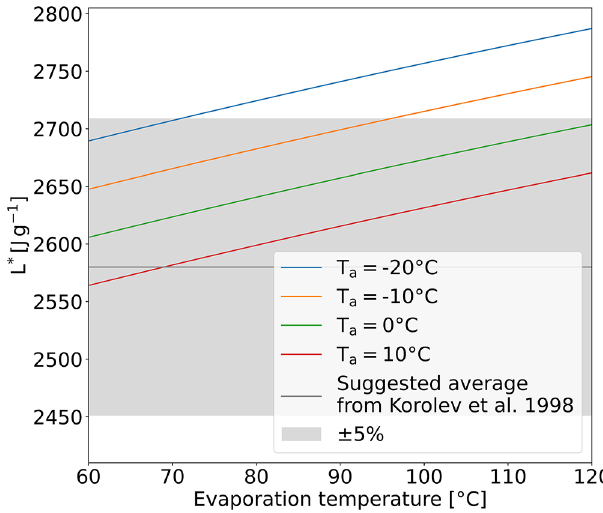
Figure 3. The energy needed to heat and evaporate water ( L ∗ ) plot- ted versus the evaporation temperature T e